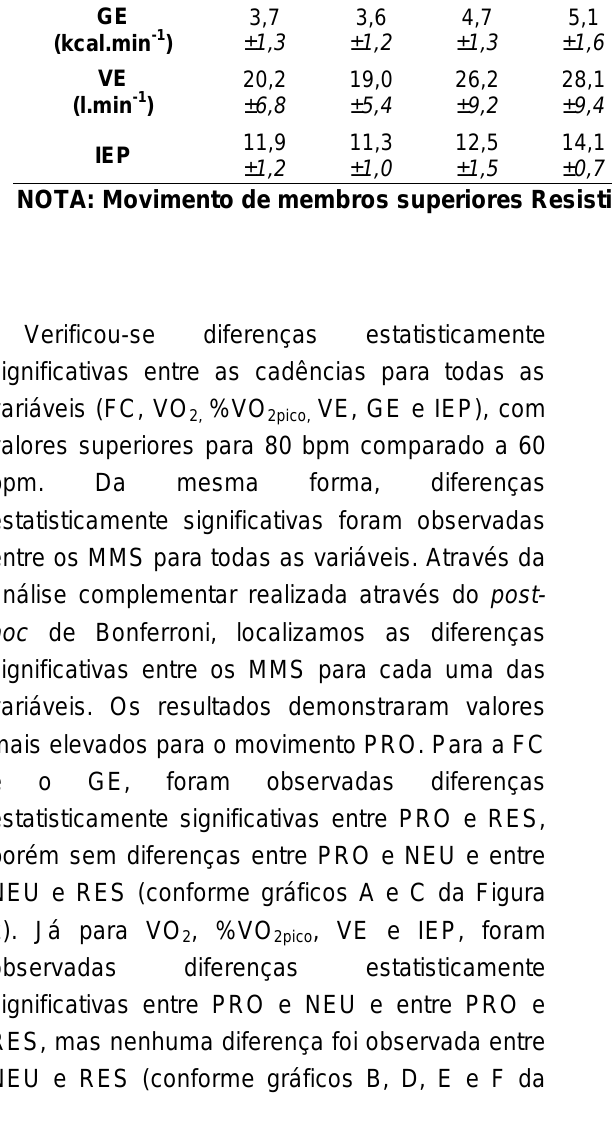
), Gasto Energético (GE), Ventilação (VE) e 2pico